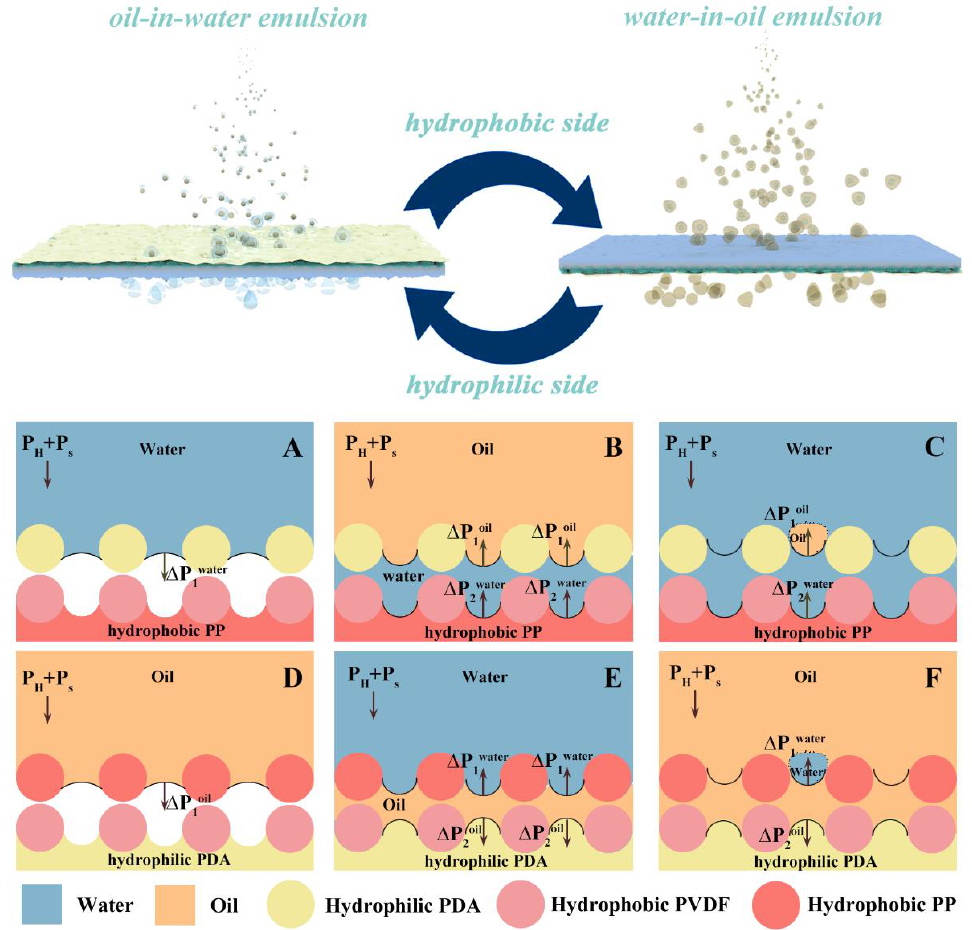
Figure 6. Schematic diagram of mechanism in as − prepared Janus membrane for separating ( A , B ) ter/light oil mixtures, ( C ) oil-in-water emulsion, ( D , E ) heavy oil-water mixtures, and ( F ) water-in-oil water/light oil mixtures, ( C ) oil − in − water emulsion, ( D , E ) heavy oil – water mixtures, and ( F ) wa- ter − in − oil emulsion.